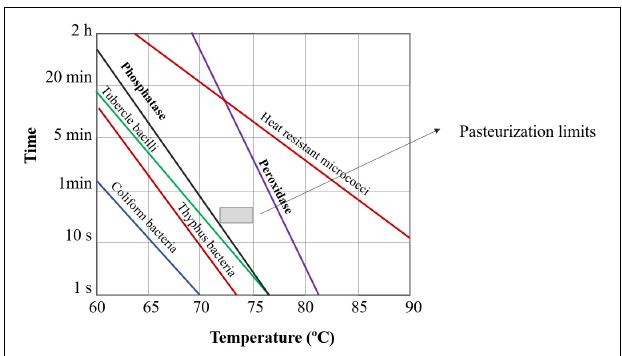
FIGURE 1 | Effect of temperature and holding time on the lethality of common microorganisms and enzymes current in raw milk, indicating the pasteurization conditions [adapted from Bylund et al. (2)].